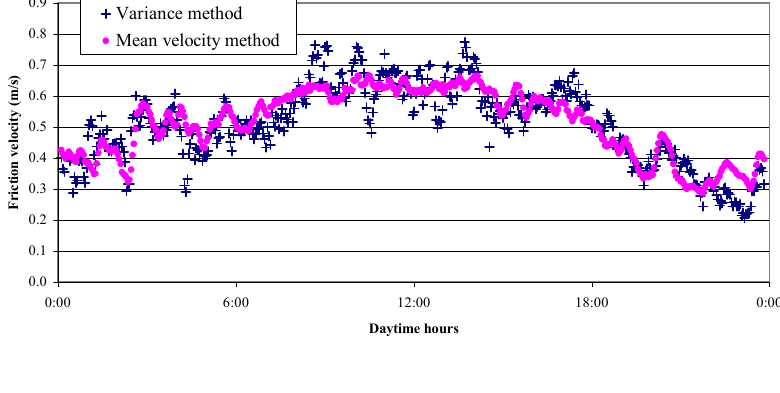
Fig. 6. Values of the friction veloci- ties. Comparison between the variance (cross) and the mean wind methods (dot), plot RT, 25 July 1997. The mean wind method data are from Richard (2000).